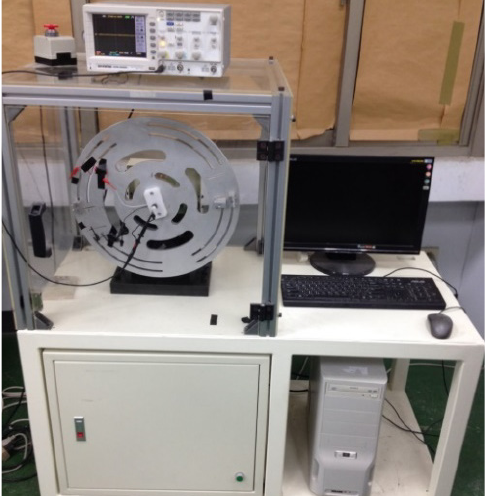
Figure 9. Experiment setup for the energy harvester verification.